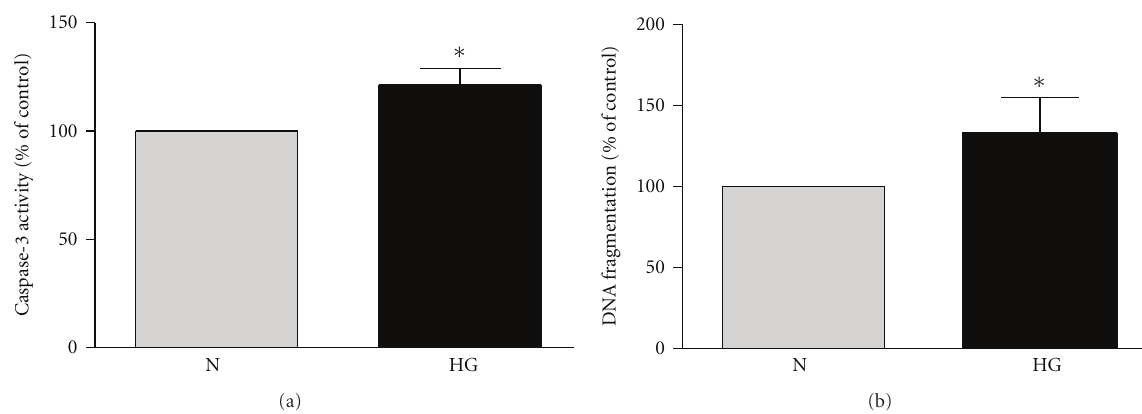
Figure 4: Continuous high (25mM) glucose induces apoptosis of BRP . Subconfluent cells in 30mm 2 dishes were exposed to normal (N, 5.6mM) and high (CG, 25 mM) glucose for 4 days. (a) High glucose activates caspase-3. After 4 days, the cells were washed twice with ice-cold PBS, lysed and apoptosis was measured using colorimetric caspase activity assay. Data are represented as Means ± SEM of 6 separate experiments. ∗ P = . 0315 versus N. (b) High glucose induces DNA fragmentation. After 4 days, DNA fragmentation was measured using Cell Death Detection ELISA plus (Roche, Hertfordshire, UK). Data are represented as Means ± SEM of 5 separate experiments. P = . 043 versus N.